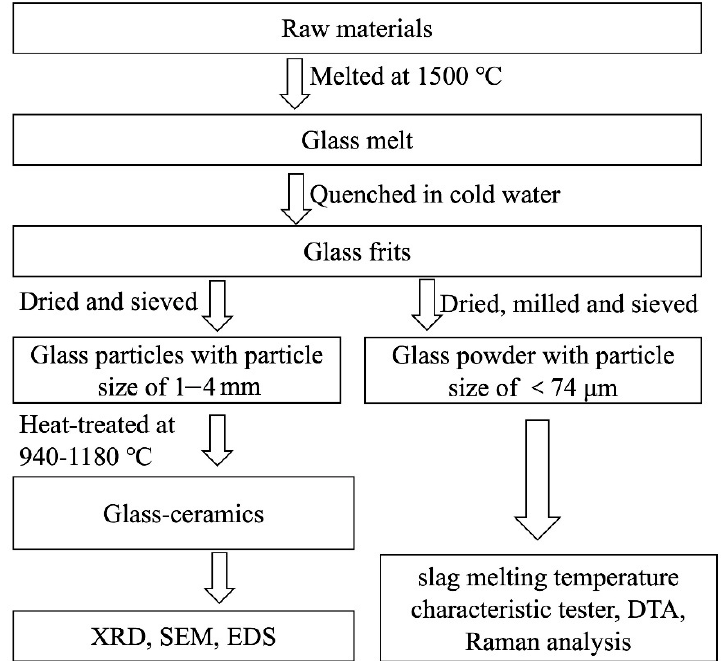
Figure 1. The process flow diagram of the experiment.